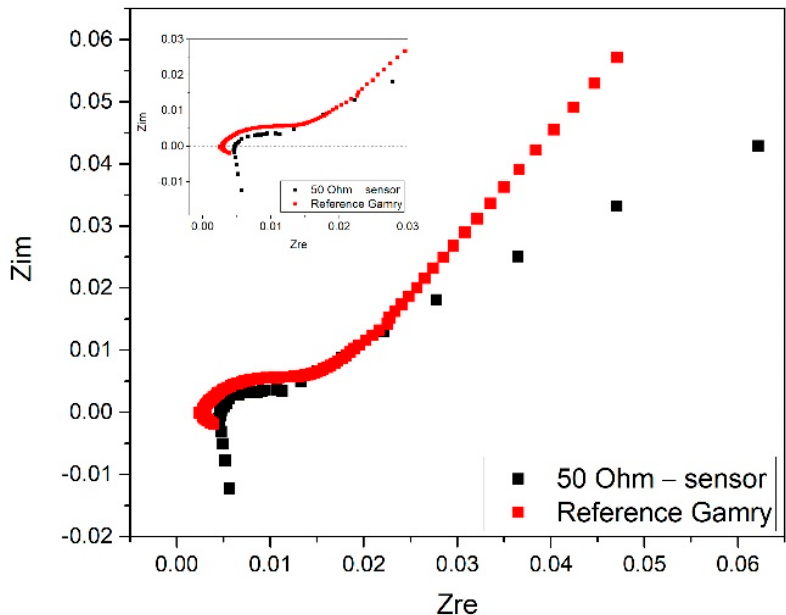
Table 2. Resistances measured at 1 kHz and the voltage parameter variations before and after EIS measurements with the 100 Ω sensor.